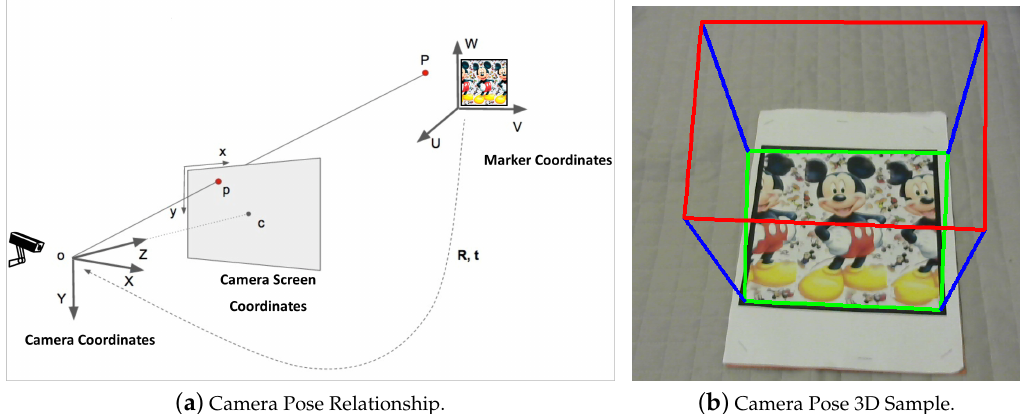
Figure 12. ( a ) relationship between the marker coordinates and the camera coordinates; ( b ) sample virtual 3D shape rendered on the top of the